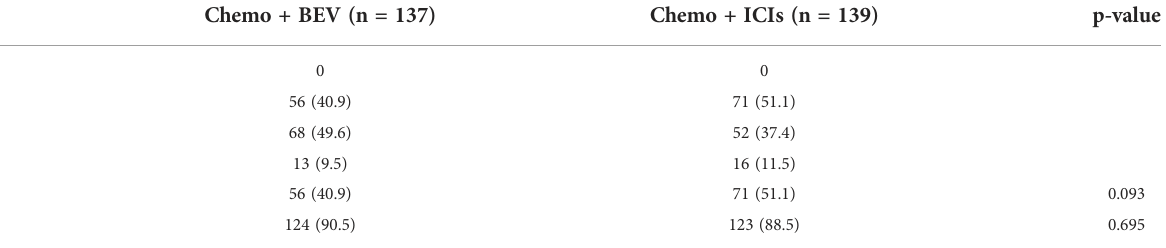
TABLE 2 Treatment response.